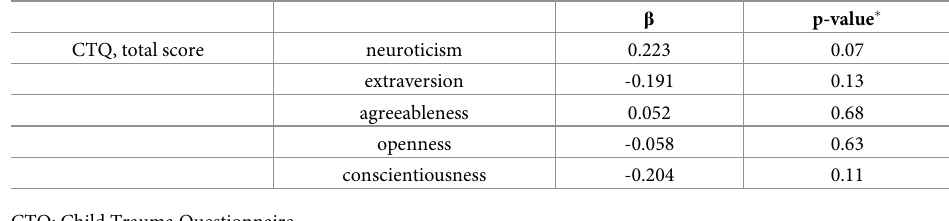
Table 4. Association between childhood maltreatment and personality traits.